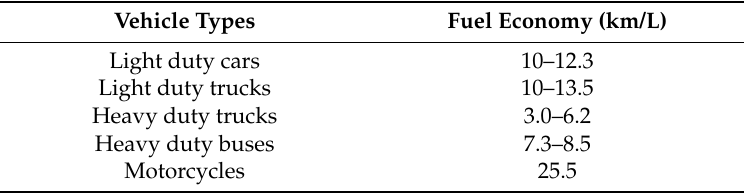
Table 1. Fuel economy of each vehicle type used in this study.